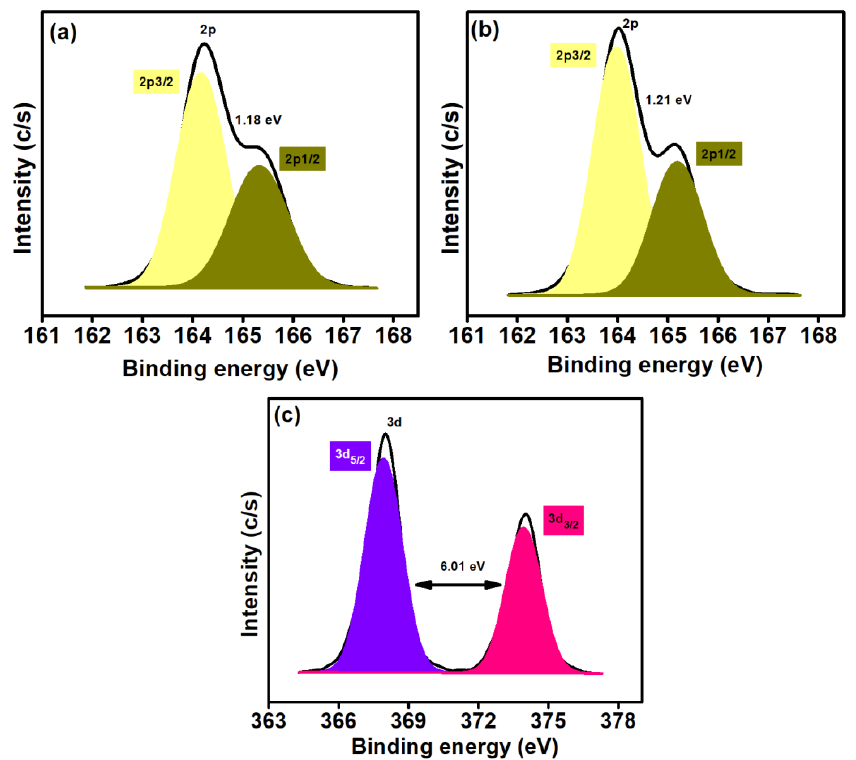
Figure 6. ( a , b ) S2p chemical state analysis of HS-rGO 2% @ g -C 3 N 4 and AgNP S -S-rGO 2% @ g -C 3 N 4 ( c ) Ag3d analysis for AgNPs-S-rGO 2% @ g -C 3 N 4 .